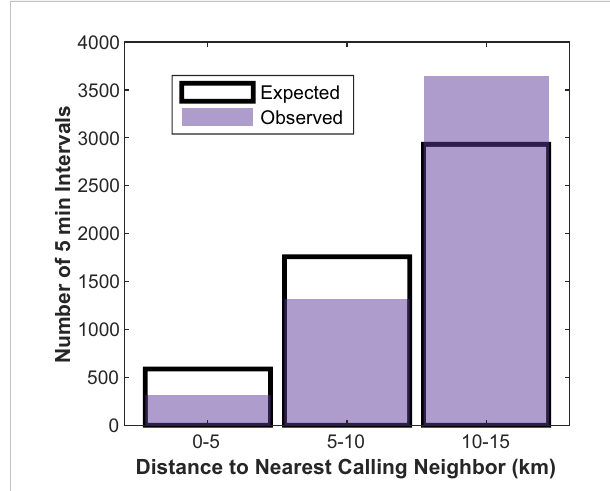
FIGURE 2 The observed (purple) and expected (black) spatial distributions of a nearest calling conspeci fi c with respect to a focal animal, grouped into 5 km bins. The counts are in units of the number of 5 min intervals of the CRAWL tracks, aggregated over all seasons. Expected values were calculated assuming a random distribution of the nearest neighbor with respect to the focal animal (Equation